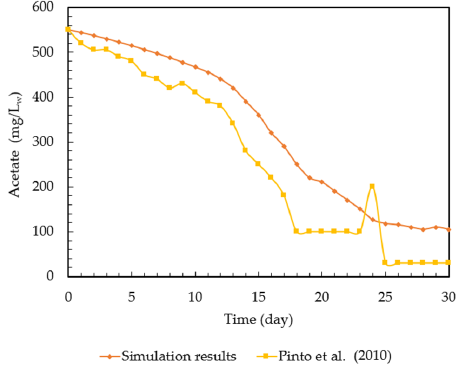
Figure 3. The acetate consumption rate (MFC) [20].